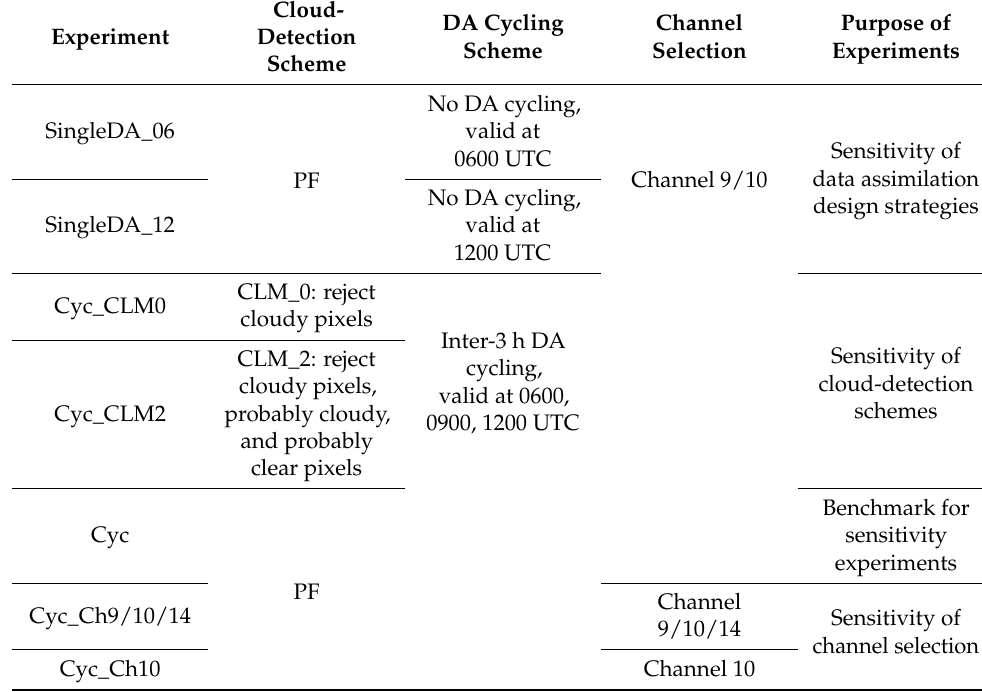
Table 2. The setting of all the assimilation